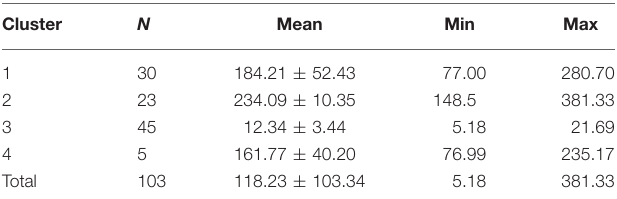
TABLE 3 | GGI scores representing the mean values for the lower limbs in children with bilateral cerebral palsy in specified clusters. Cluster N